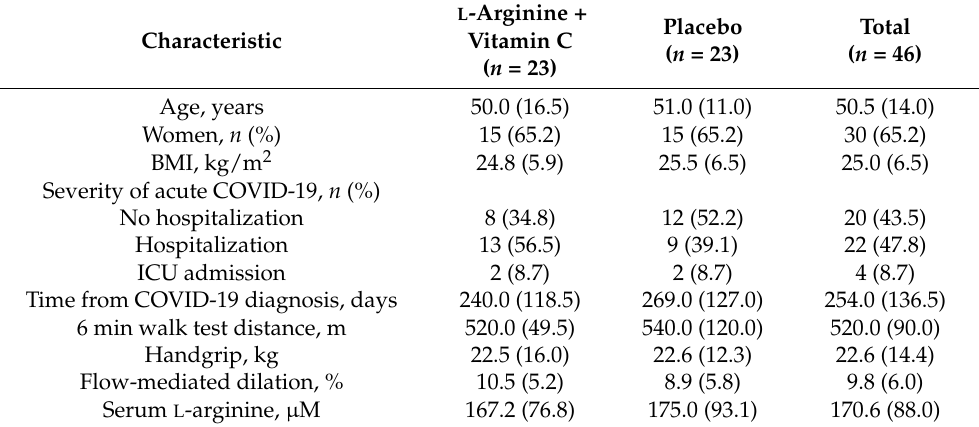
Table 1. Baseline characteristics of study participants.